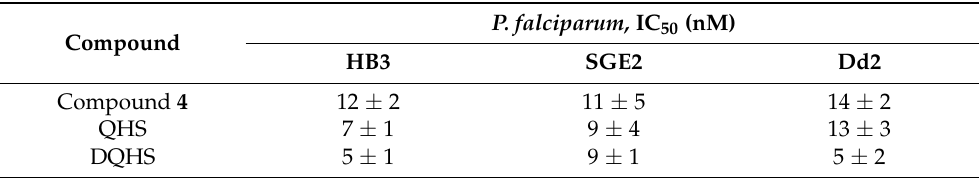
Table 1. In vitro antimalarial activity of hybrid 4 and parent compounds against P. falciparum strains; data from [41].